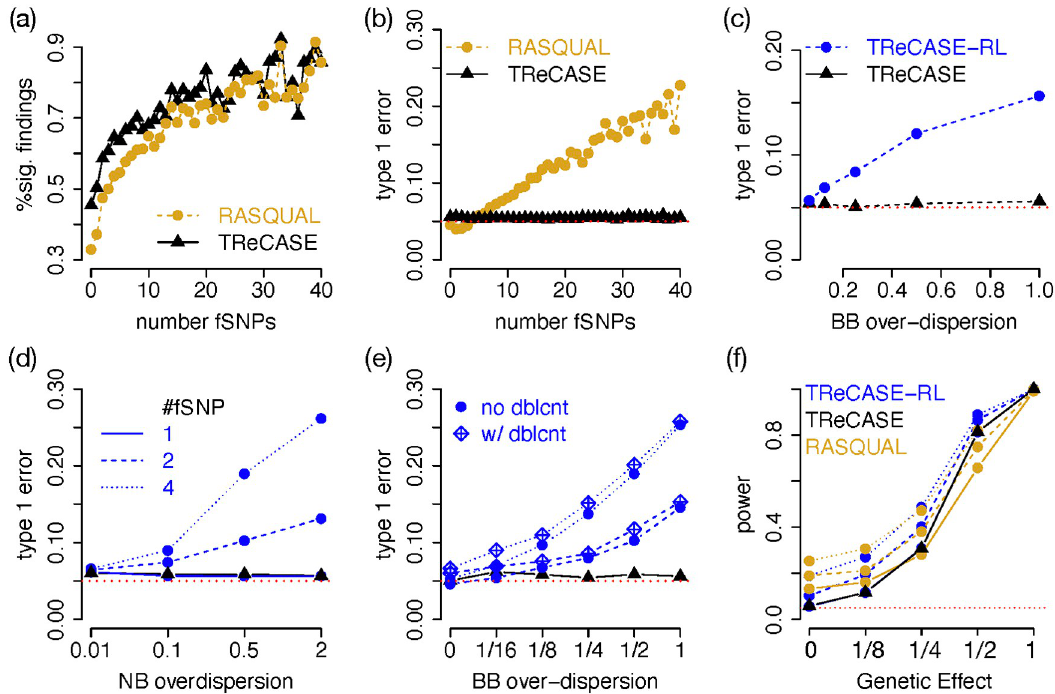
Fig 5. Compare TReCASE vs. RASQUAL. (a) Compare the number of significant findings (q-value < 0.05) between TReCASE and RASQUAL for different number of feature SNPs (fSNPs) using Geuvadis data with sample size of 280. (b) The number of significant findings (p-value < 0.05) after permuting SNP genotypes, which provides an empirical estimate of type I error. The results of panels (c)-(f) are from simulations with 10,000 replicates. (c) Evaluation of type I error for TReCASE and TReCASE-RL when there is smaller over-dispersion within a sample and larger over-dispersion across samples. We assume there are two heterozygous fSNPs per gene and per sample. Total read counts were simulated with negative binomial with over-dispersion 0.5. The results in (d)-(f) assume there is no over-dispersion across SNPs within an individual. (d) Type I error when the over-dispersion of negative binomial (NB) and beta-binomial (BB) are the same. (e) Effect of double counting. We assume 15% double counting and simulate the data assuming NB over-dispersion to be 0.5. (f) Power analysis when the over-dispersion of NB and BB are both